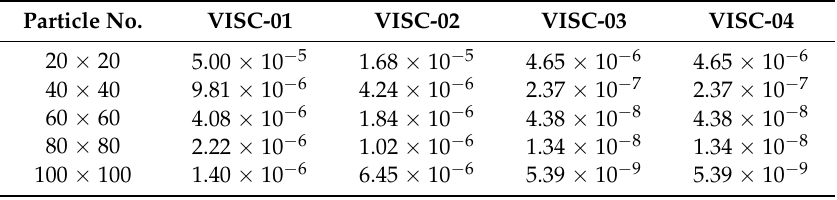
Table 1. Mean errors with different particle numbers and viscosity calculation methods under the uniform particle distribution. VISC, Viscosity Force